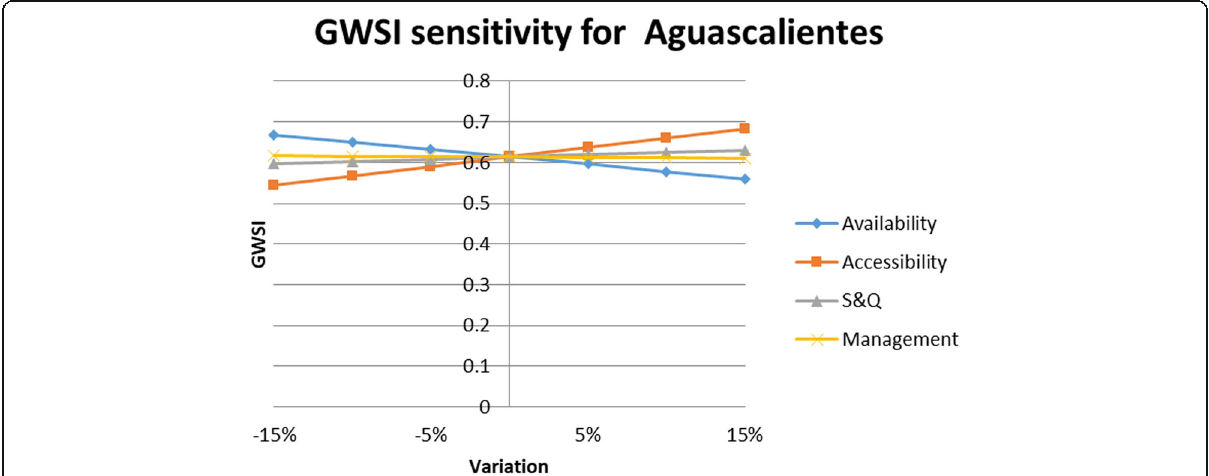
Fig. 4 Sensitivity analysis for the state of Aguascalientes